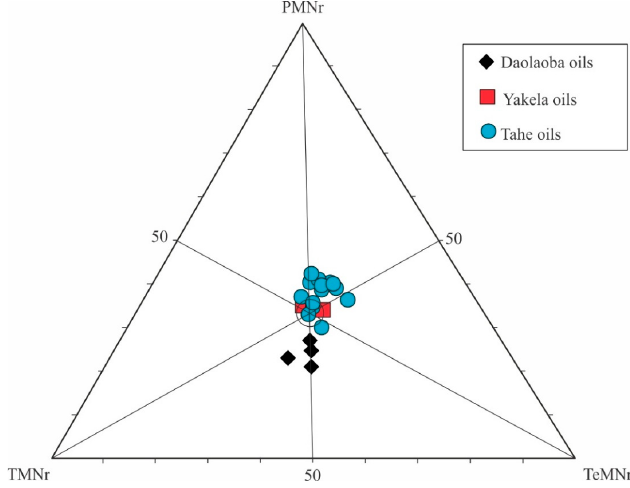
Figure 10. TMNr, TeMNr, and PMNr ternary diagrams of 20 selected oils from the Tarim Basin.